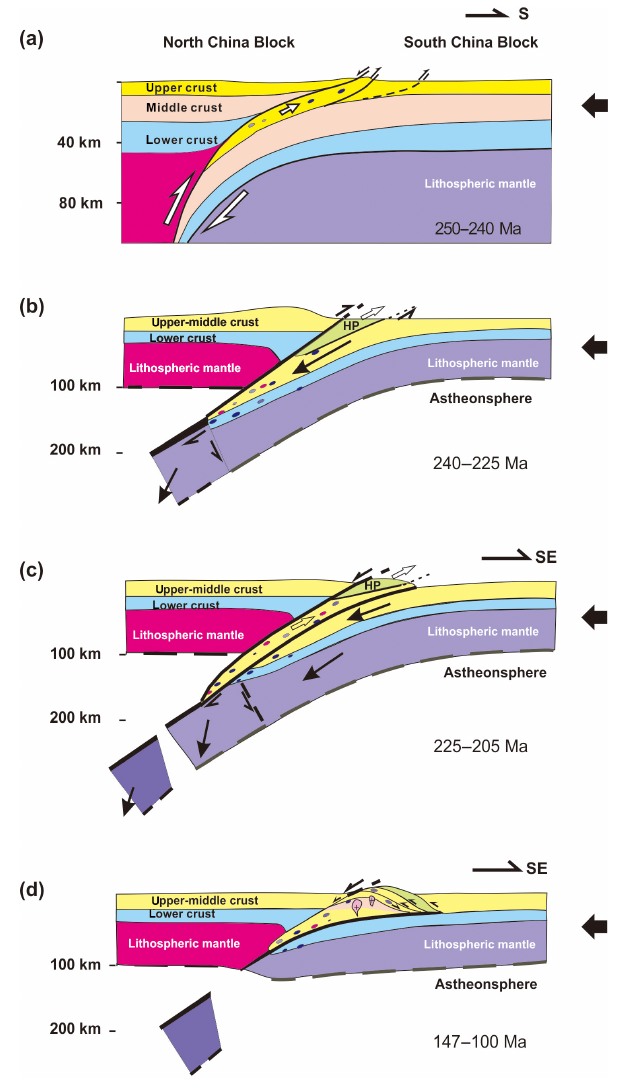
Figure 6. Subduction and exhumation history of the Sulu Terrane (modified after Xu et al., 2009b).